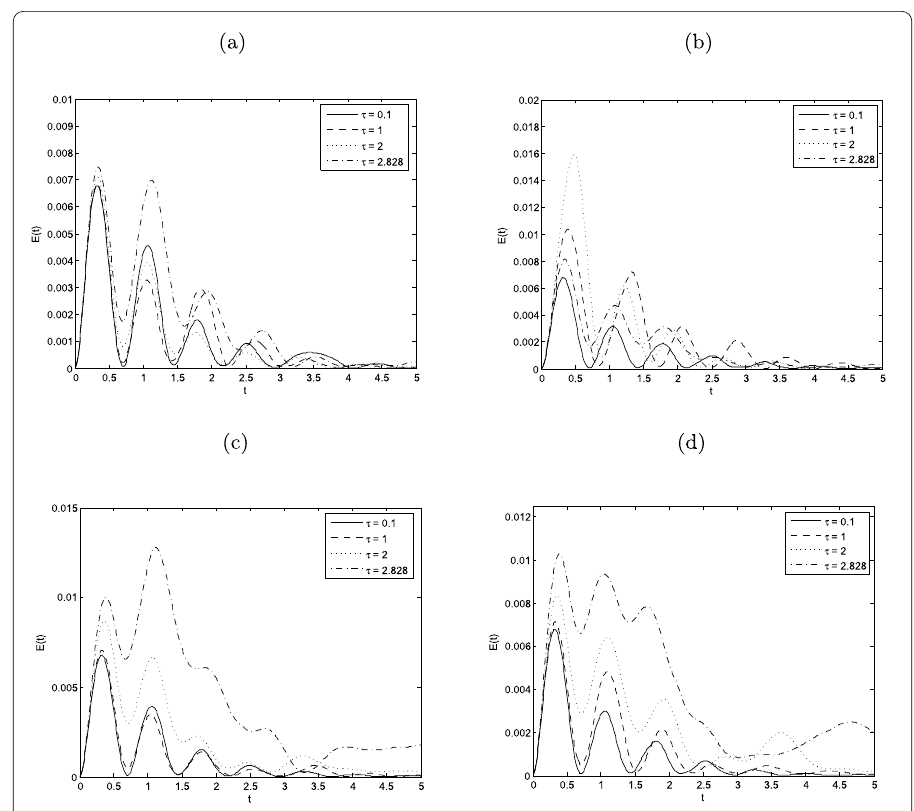
Figure 9 The energy E 0 ( t ) of the wave system (1.6)-(1.10) for different delays when a ( x ) = e ( x 1 x 2) with: a) k = 0.1; b) k = –0.1; c) k = 0.2; d) k =